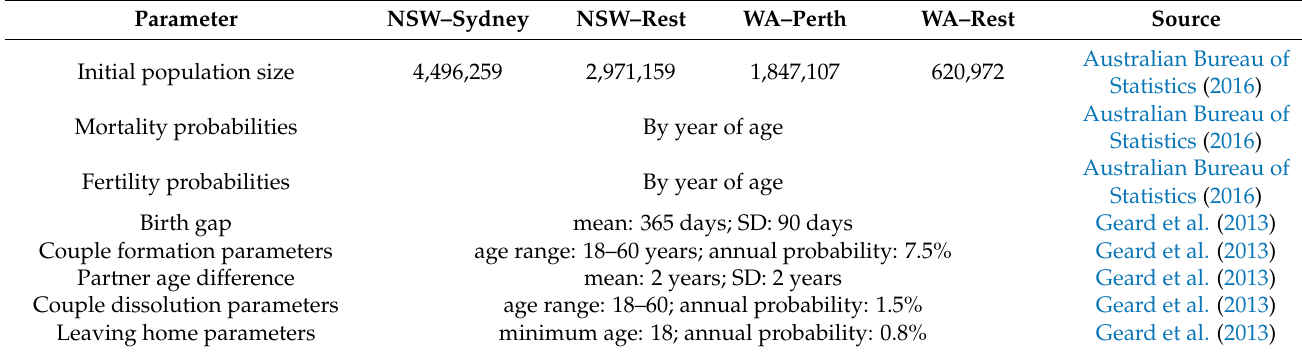
Table 2. List of parameters used in the simulation model, from Geard et al. (2013).